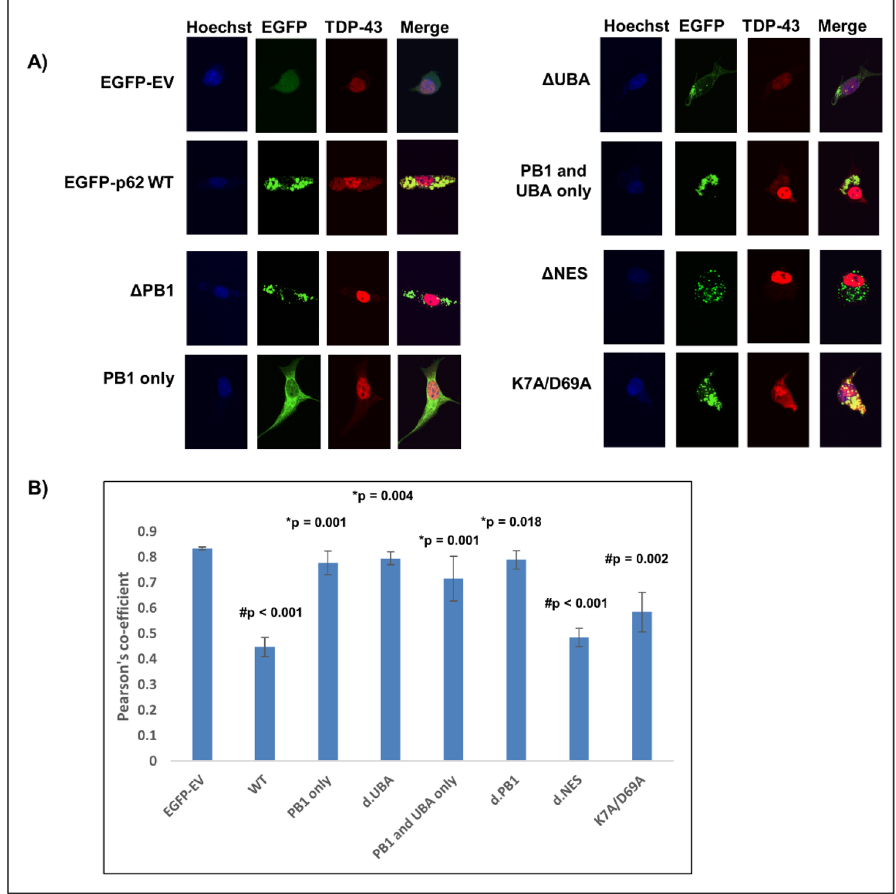
Figure 12. TDP-43 nuclear depletion requires the PB1 and UBA domains of p62, but not the nuclear export signal or self-dimerisation via the PB1 domain. ( A ) NSC-34 cells were transfected with TDP-43-tdTomato and EGFP empty vector (EGFP-EV) or EGFP-p62 (WT or deletion constructions as indicated). Cells were fixed and stained with the nuclear stain Hoechst. Images are representative of 3 independent experiments. Minimum number of cells analysed per construct = 32. ( B ) TDP-43-tdTomato co-localisation with the nucleus was determined by calculating the Pearson’s co-efficient with ImageJ. Statistical analyses were performed using SPSS, with Bonferroni and Dunnet T3, p = 0.05. #compared with EGFP-EV, *compared with EGFP-p62